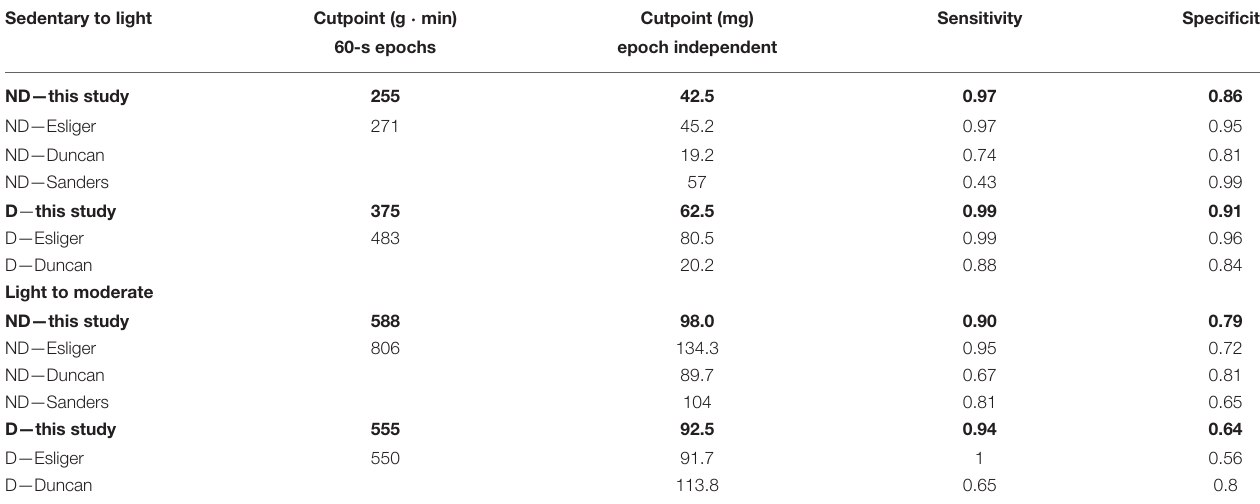
TABLE 3 | Intensity cutpoints and associated sensitivity and specificity for sedentary to light PA, and light to moderate PA, for the present study and the studies of Esliger et al., Duncan et al., and Sanders et al. cutpoints from both studies were converted to 60-s epoch equivalents at 100Hz. Sedentary to light